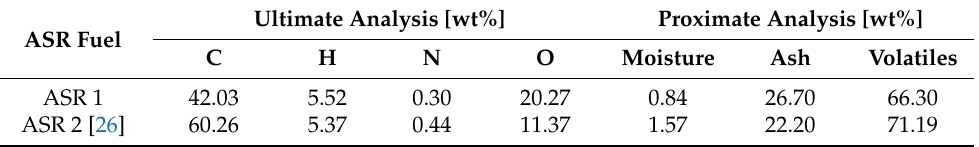
Table 3. Characterization of the sample compositions for the numerical